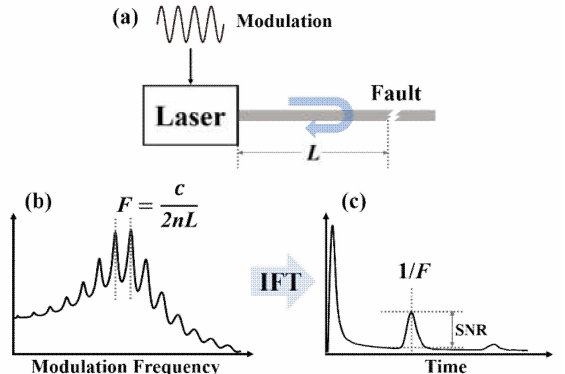
Figure 1. Schematic of fiber fault detection by frequency resonance method. ( a ) Setup: a modulated laser receiving its own delayed feedback from the fault point; ( b ) modulation response curve and ( c ) its inverse Fourier